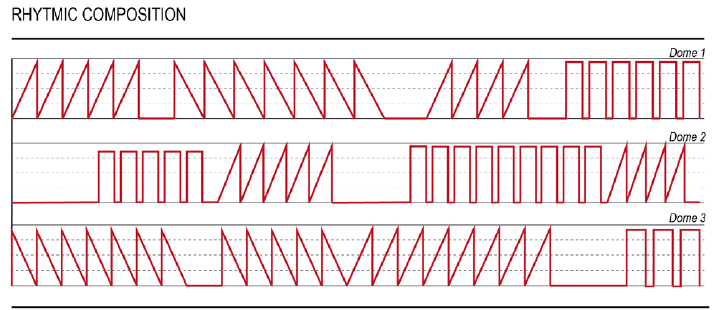
Figure 9. Example of rhythmic VMC created for the Hedonic Haptic Player, retrieved from in